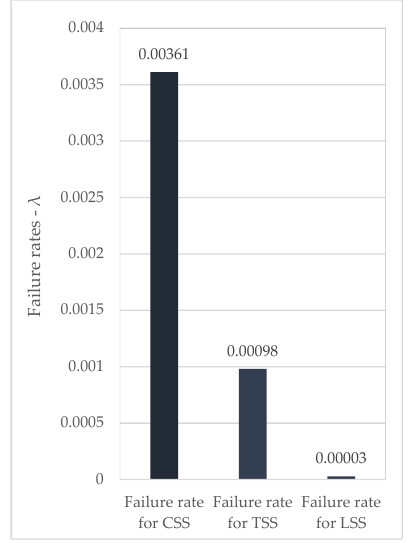
Figure 10. Failure rates — λ CSS, λ TSS, and λ LSS .